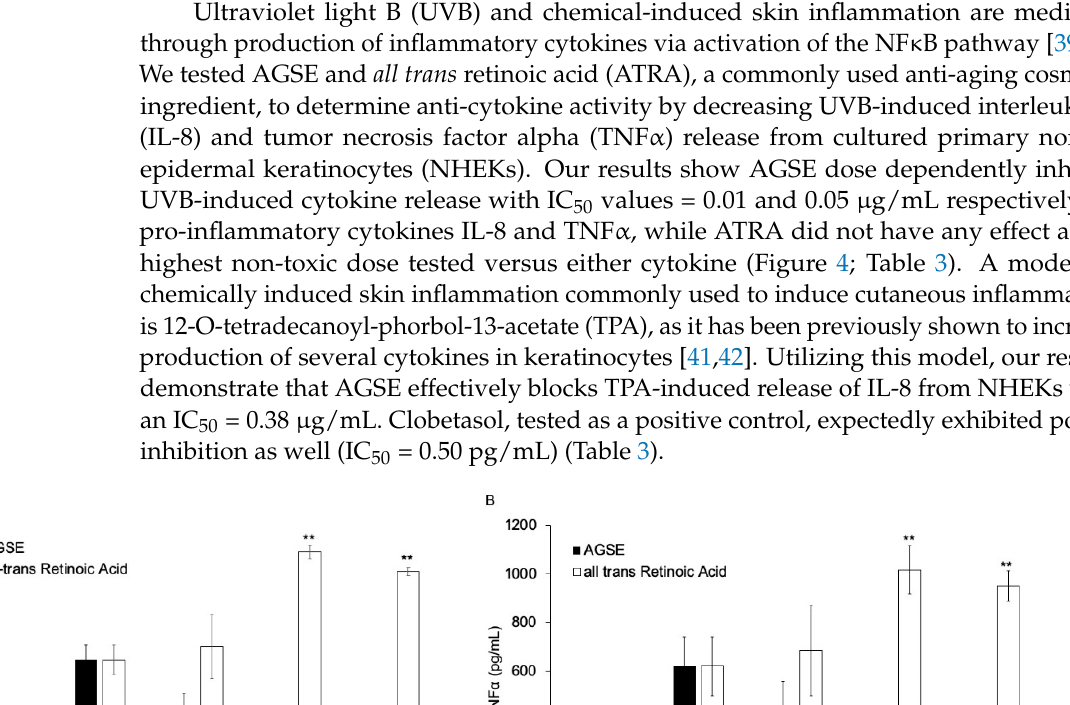
Figure 3. AGSE possesses potent antioxidant activity . ( A ) Cell ‐ free antioxidant capacity of actives were measured via the ABTS assay by metmyoglobin. ( B ) Intracellular antioxidant activity was measured in NHDFs after incubation for 3 h. The activity was determined using DCFH ‐ DA marker of oxidative stress after H 2 O 2 ‐ induction. The IC 50 is the concentration of compound producing half maximal inhibition. Data represents mean ± SD from three independent experiments.